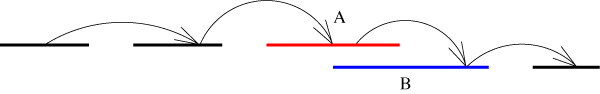
Chimera detection from scaffold. Contigs shown here are from one scaffold. A and B are two consecutive contigs large enough to overlap. If they don't overlap, there is a chance that either A or B is a chimera produced due to mis-assembly.